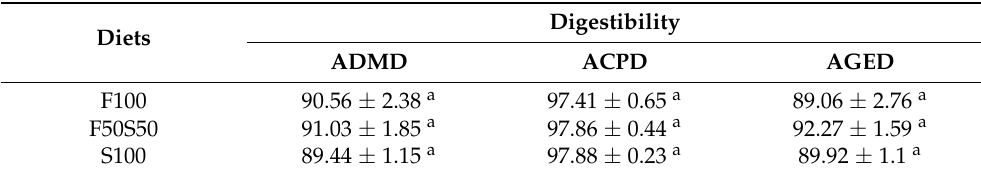
Table 4. Apparent digestibility (%) for dry matter (ADMD), crude protein (ACPD) and gross energy (AGED) of three experimental diets. Digestibility Diets ADMD